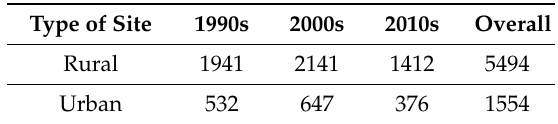
Table 1. The average exceedances over the last three decades.